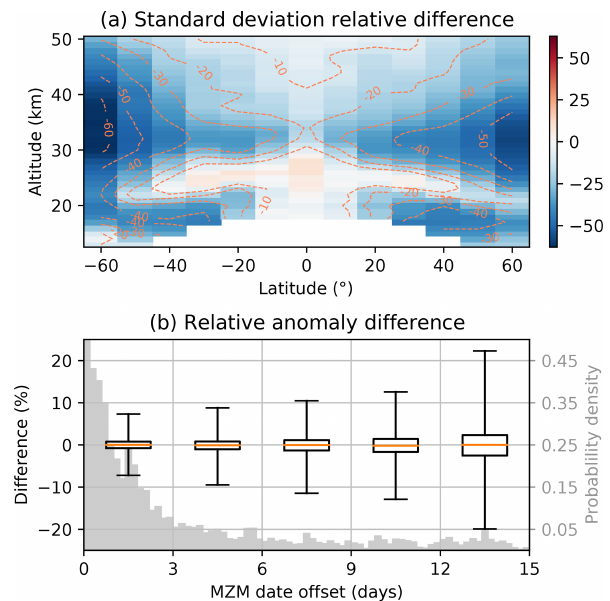
Figure 1. Effect of the sampling correction on OSIRIS v7.2 ozone. (a) Relative difference (in percent) of the mean ozone standard de- viations. The standard deviations are calculated in monthly 10 ◦ lat- itude by 1 ◦ longitude bins, averaged across longitude and time, and then subtracted (corrected minus uncorrected). (b) Relative anomaly differences as a function of how far the mean date of the MZM is from the middle of the month. The box and whisker plots represent 3d bins, with the whiskers extending from the 1st to the 99th percentile (outliers are not shown). The gray histogram shows the distribution of all MZM data along the same x